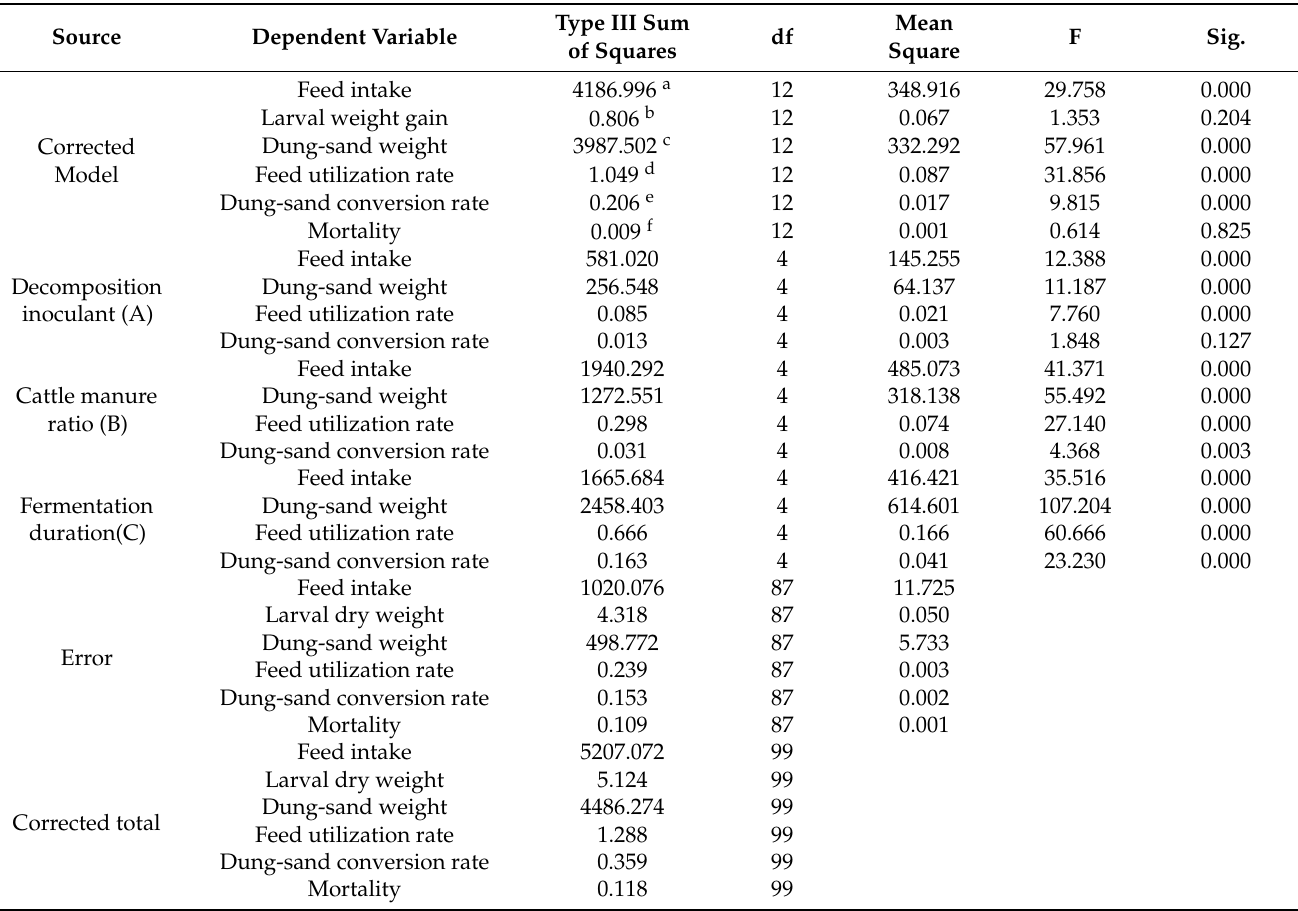
Table 6. Tests of inter-subjects